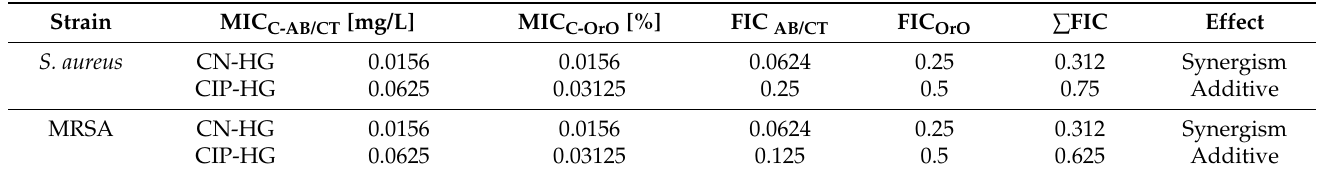
Table 3. Combination effects between OrO-NP-HG and CN-HG or CIP-HG.